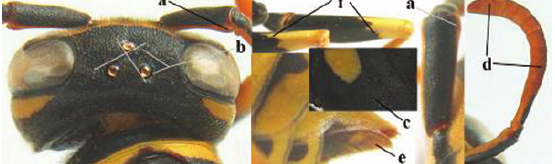
12 Scapus slightly widened apically in dorsal view (a), if scapus intermediate then ocellar triangle acute anteriorly (b); change in sculpture between mesepisternum and epicnemium frequently gradual (c; = epicnemial ridge indistinct); apical half of antenna more or less brownish dorsally (d); apical half of hypopygium (= sternite VI) often largely black and brown or largely brown, slightly darker than apex of last tergite (e); border of black and yellow on outer side of middle and hind femora often sharp and often without orange intermediate area in Balkan populations (f); often smaller species; S Europe, W Asia P. associus Kohl,